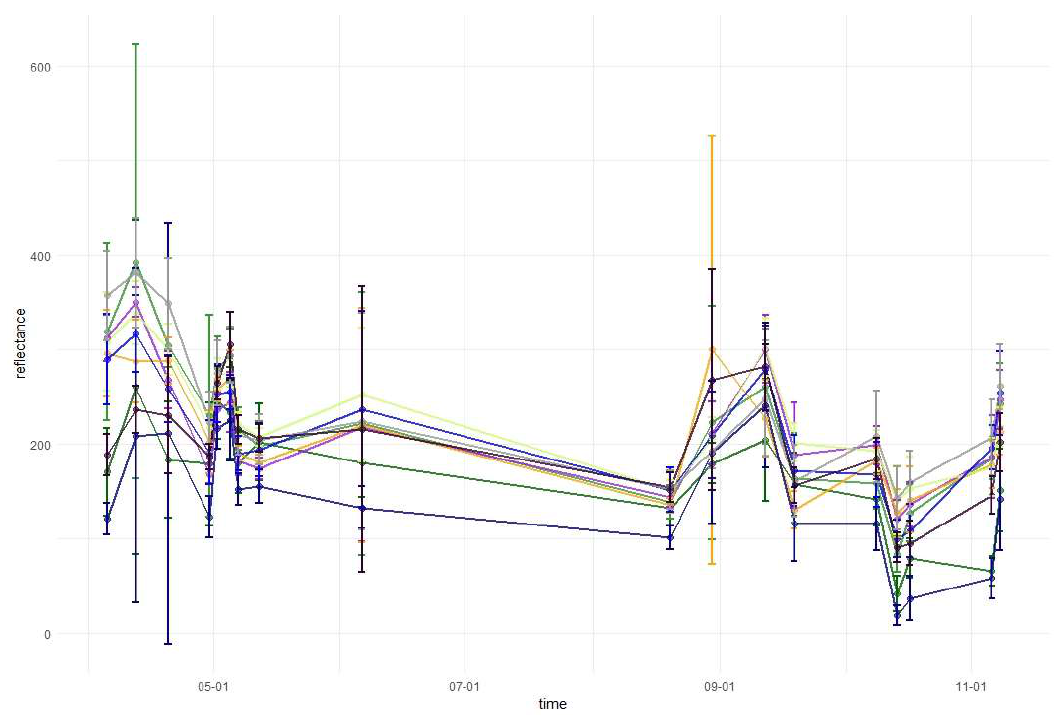
Figure A1. Mean and standard deviation values of reflectance in the visible blue band.